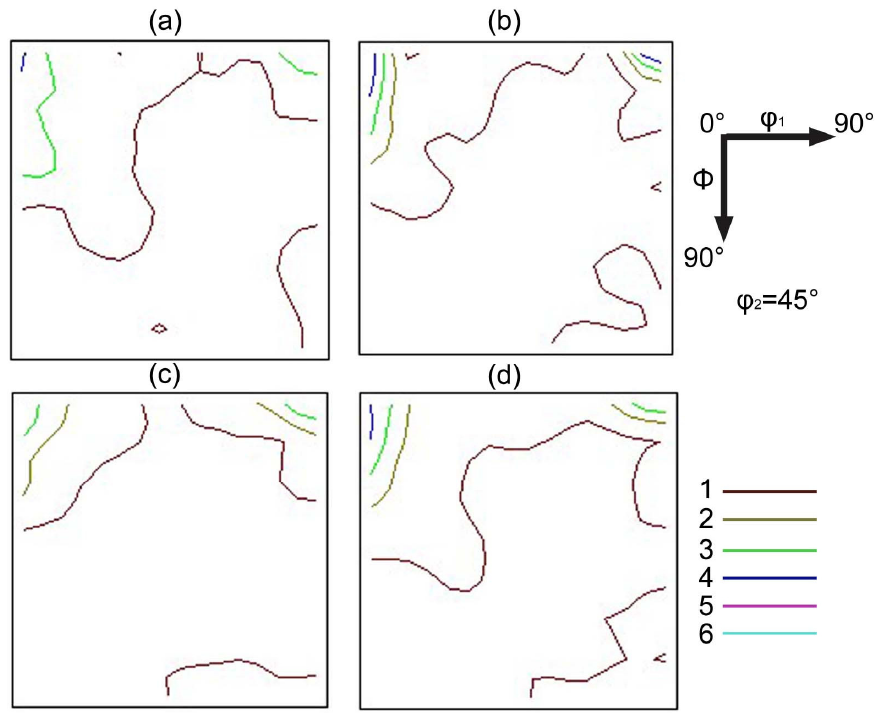
Figure 9. ODFs at ϕ 2 = 45 ◦ of hot-rolled bands: ( a ) Nb-free, ( b ) Nb-0.005 wt%, ( c ) Nb-0.009 wt% and Figure 9. ODFs at φ 2 = 45° of hot-rolled bands: ( a ) Nb-free, ( b ) Nb-0.005 wt%, ( c ) Nb-0.009 wt% and Figure 9. ODFs at φ 2 = 45° of hot-rolled bands: ( a ) Nb-free, ( b ) Nb-0.005 wt%, ( c ) Nb-0.009 wt% and ( d ) Nb-0.025 wt%. ( d ) Nb-0.025 wt%. ( d ) Nb-0.025 wt%. Figure 9. ODFs at φ 2 = 45° of hot-rolled bands: ( a ) Nb-free, ( b ) Nb-0.005 wt%, ( c ) Nb-0.009 wt% and ( d ) Nb-0.025 wt%.